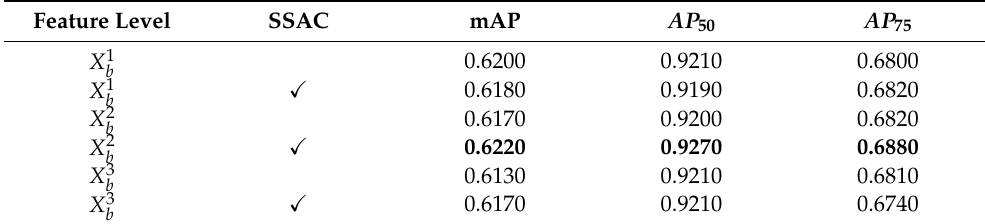
Table 5. The top-level performance derived from different feature